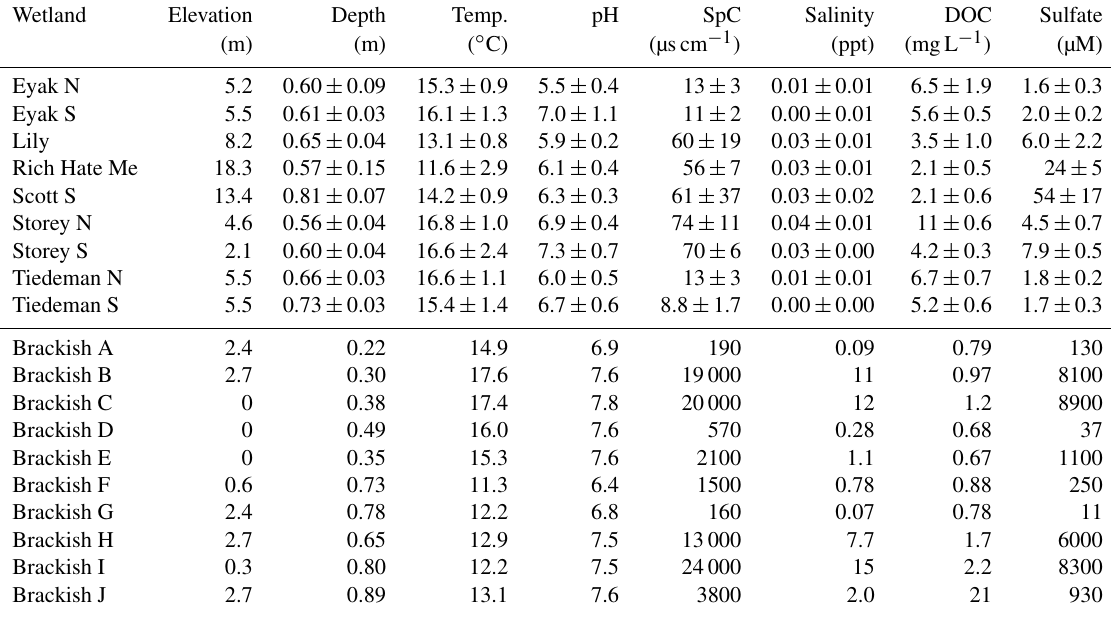
Table 1. Water column physical and chemical characteristics (mean ± SD) of the wetlands sampled in the Copper River delta including elevation, depth, temperature, pH, specific conductivity (SpC), salinity, dissolved organic carbon (DOC), and sulfate concentrations. For the freshwater wetlands, physicochemical parameters are from spot measurements of the hypolimnion conducted throughout summer 2014 ( n = 4 per freshwater wetland), whereas DOC and sulfate were measured in the surface layer in June and August 2014 (5 sites × 2 time periods, n = 10 per wetland). For the brackish wetlands, physicochemical parameters are from one spot measurement of the surface layer. Tidal brackish wetlands A–E were sampled in June and F–J were sampled in